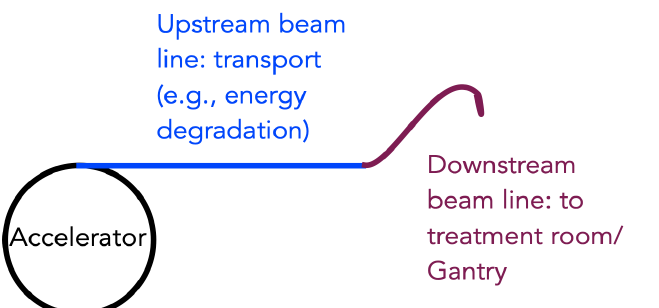
Figure 1. Schematic picture of a proton therapy facility. We identify here the ’upstream’ and ’downstream’ beamlines that we will refer to in the